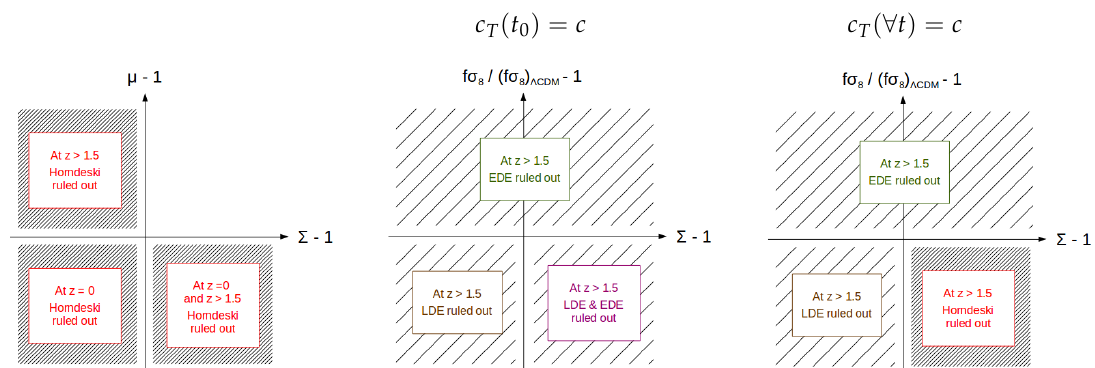
Figure 2. Schematic diagrams of the correlations of LSS observable giving the diagnostic of linear Horndeski theories valid for both cases c T ( t 0 ) = c and c T ( t ) = c (left diagram). The diagnostic of ∀ the DE scenario embedded within linear Horndeski theories is shown for the case c T ( t 0 ) = c (middle diagram) and for the case c T ( t ) = c (right ∀